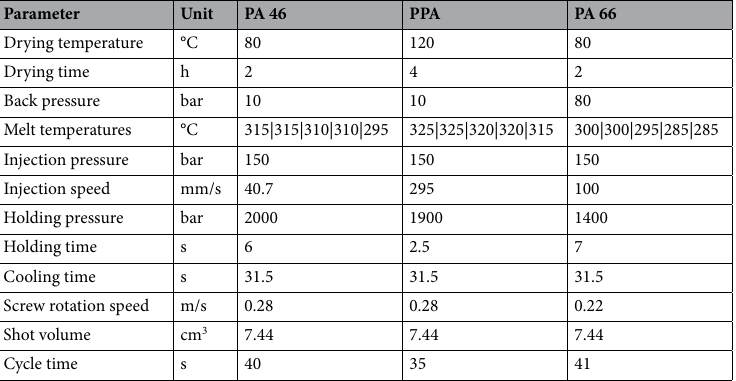
Table 2. Experimental molding conditions for manufacturing polymeric cages of the three selected material